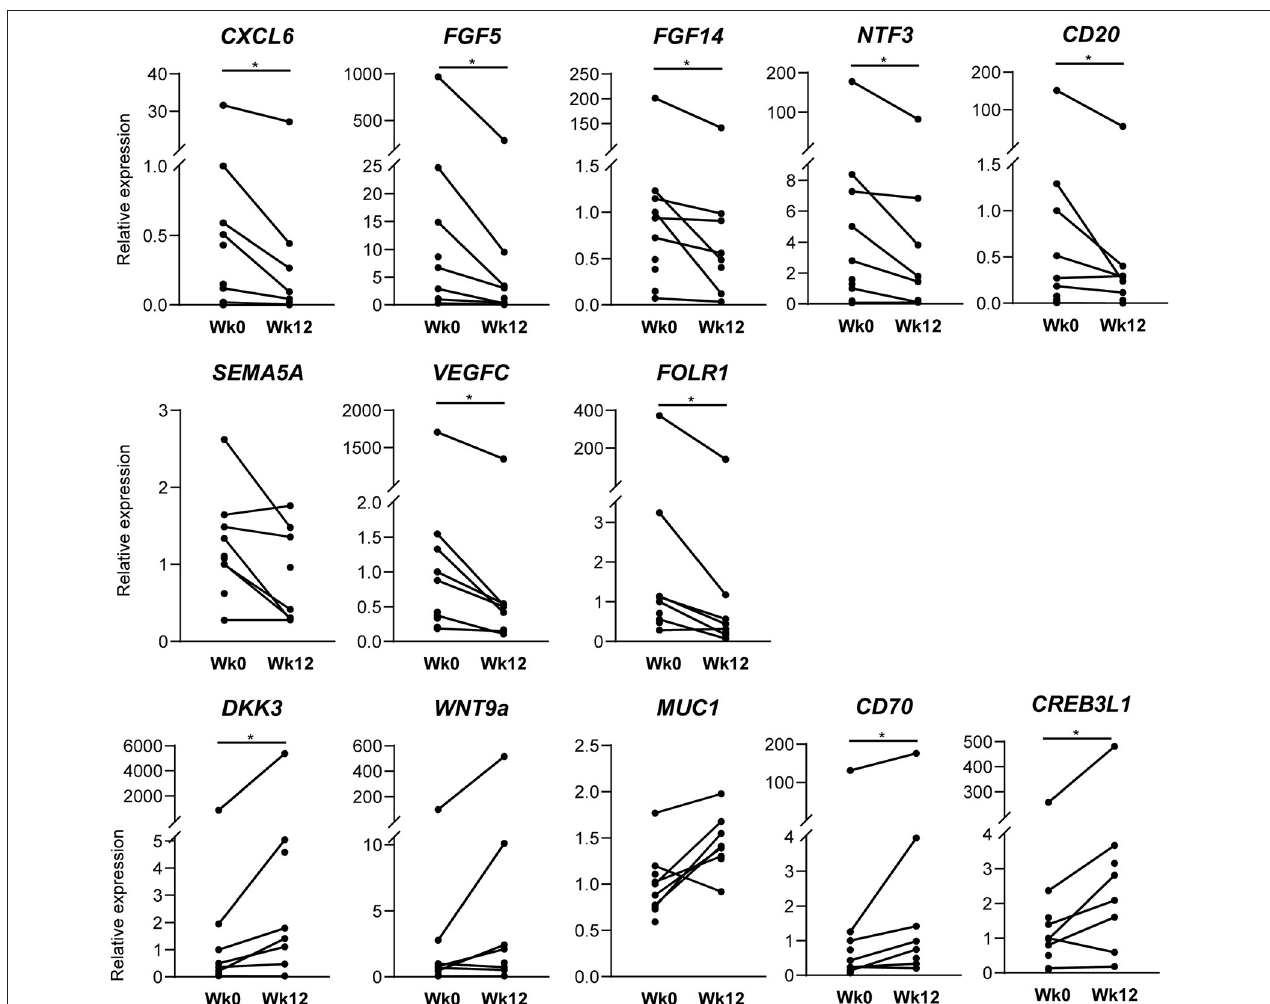
FIGURE 4 | Confirmation of RNA sequencing analysis by qPCR. Real-time quantitative polymerase chain reaction analysis of synovial tissue of baseline ( n = 10) and after 12 weeks ( n = 8) of ustekinumab treatment confirms the differential expression of genes found in RNA sequencing: CD20, CXCL6, FGF5, fibroblast growth factor 5; FGF14; FOLR1, folate receptor 1; NTF3, neurotrophin 3; SEMA5A, semaphorin 5A; VEGFC, vascular endothelial growth factor C for downregulated DEGs; CD70, CREB3L1, CAMP Responsive Element Binding Protein 3 Like 1; DKK3, Dickkopf WNT Signaling Pathway Inhibitor 3; MUC1, mucin 1; WNT9A, WNT family member 9A for upregulated genes * p <